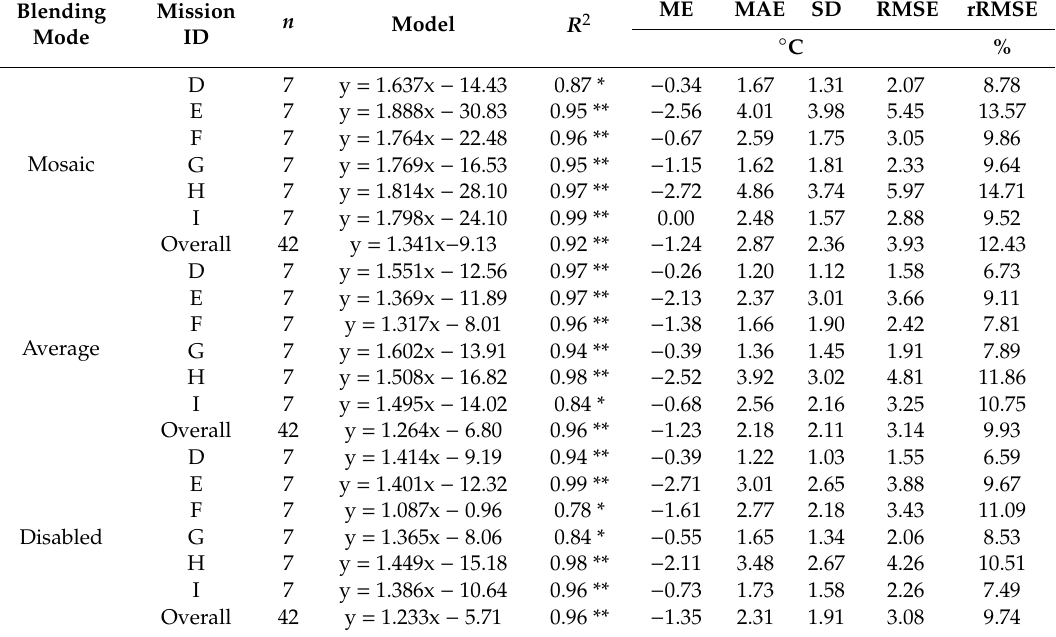
Table 4. Relationship and residuals between the temperature extracted from the orthomosaics and the reference temperature for aerial conditions according to the blending modes tested. n = number